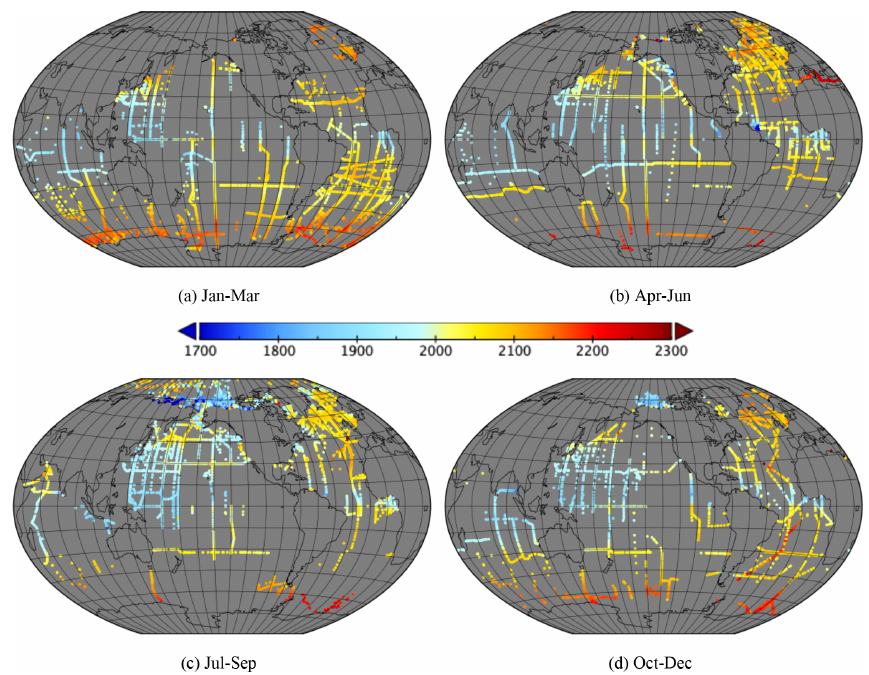
Figure 9. Mean C T (µmolkg − 1 ) divided into seasons. (a) January–March (4029 ROIs), (b) April–June (4256 ROIs), (c) July–September (4197 ROIs) and (d) October–December (2559 ROIs).